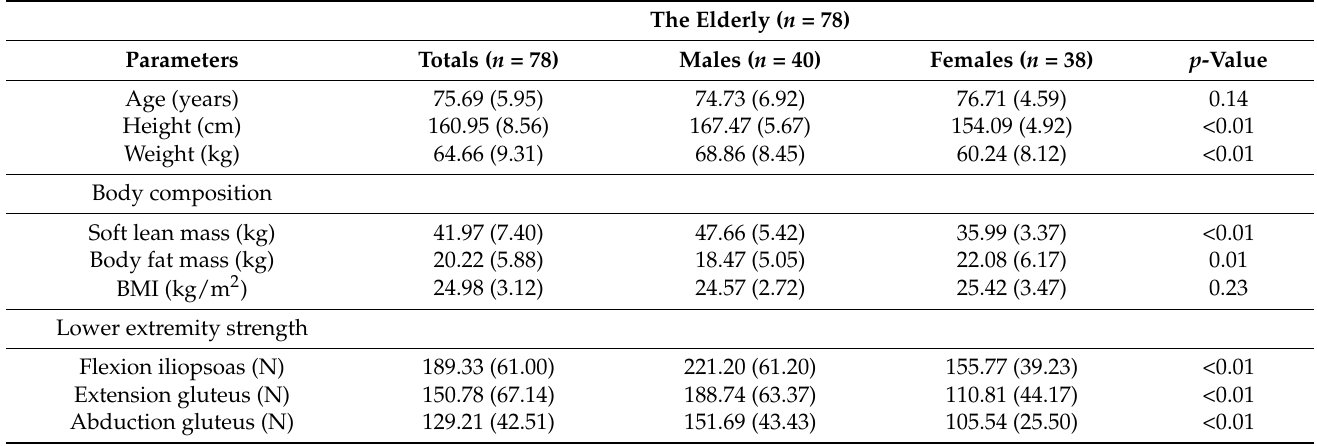
Table 2. Physical characteristics of the subjects and information on the measured muscle strength, static posture control, body composition, and gait